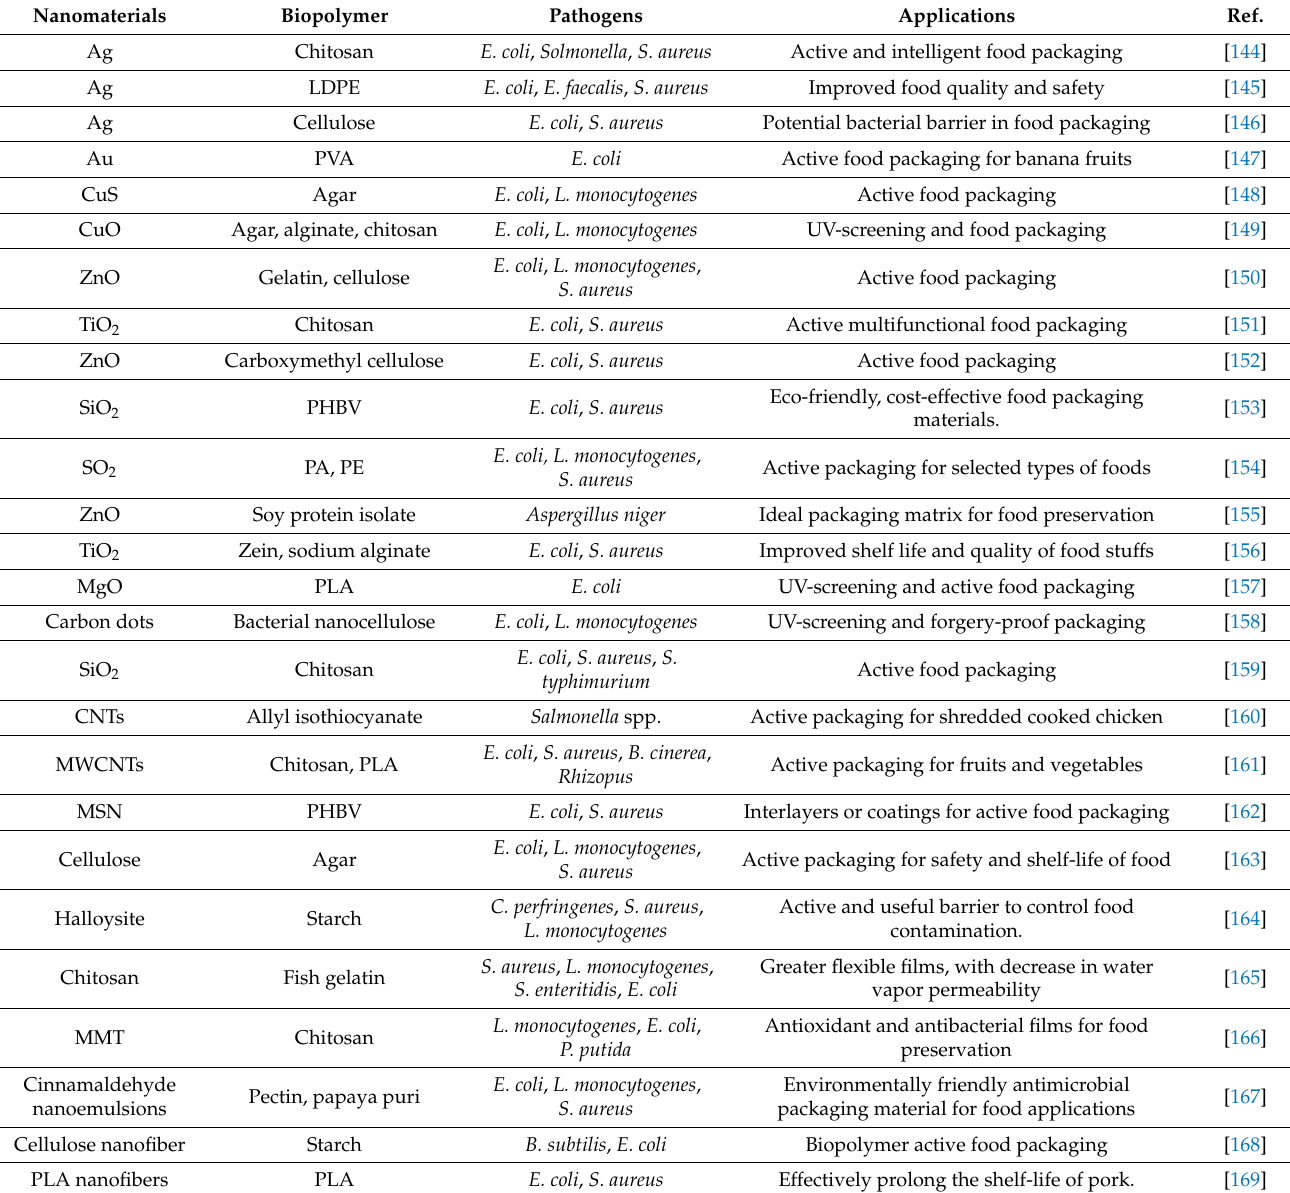
Table 3. Examples of bio-based nanocomposites investigated for their antimicrobial